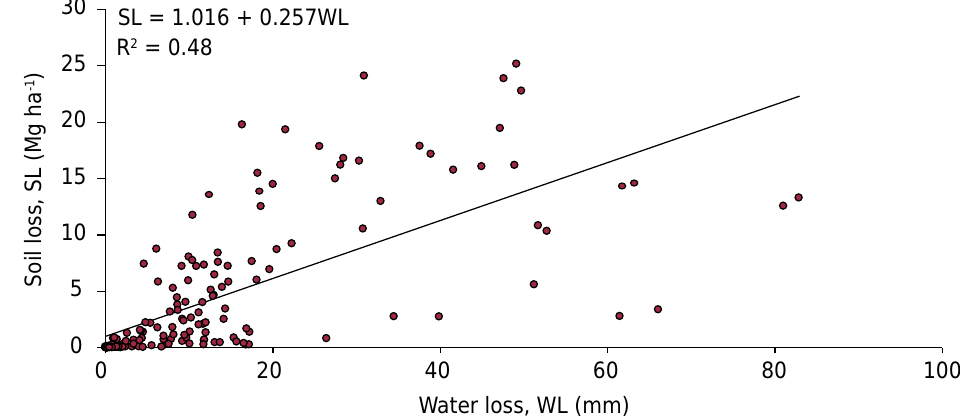
Figure 2. Relation between soil losses (SL) and water losses (WL) (individual values of each variable and average of replicates) (p<0.05).